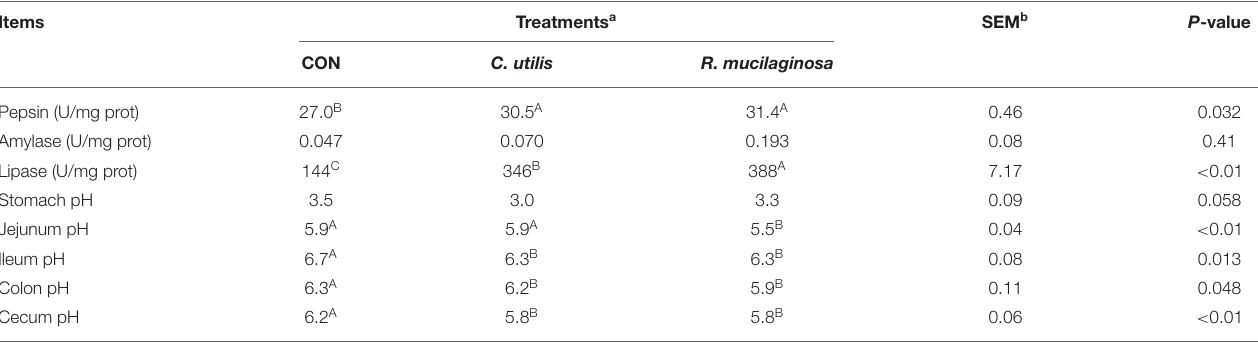
TABLE 8 | Effects of C. utilis DSM 2361 and R. mucilaginosa TZR 2014 on digestive enzyme activity of jejunal contents and pH of gastrointestinal tract in weaned piglets ( n =